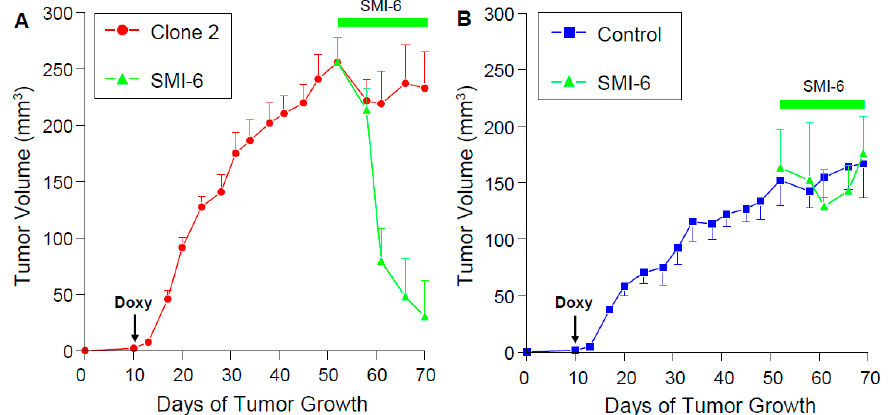
Figure 8. SMI-6 rapidly and dramatically suppresses growth of PRL-expressing breast cancer xenografts but does not affect control xenografts. Athymic nude mice were inoculated into the inguinal mammary fat pad with Doxy-regulated PRL-producing clone 2 (MDA-MB-468) ( A ) or with vector transfected control cells ( B ). On day 10, doxycycline-hyclate was added to the drinking water. On day 50, Alzet osmotic mini-pumps containing 50 mM SMI-6 and rated for continuous delivery at 0.11 µ /h for 4 weeks were implanted sc in the neck in half of the mice. Tumor volumes were measured throughout the experiment. Values are means ± SEM ( n = 5–6